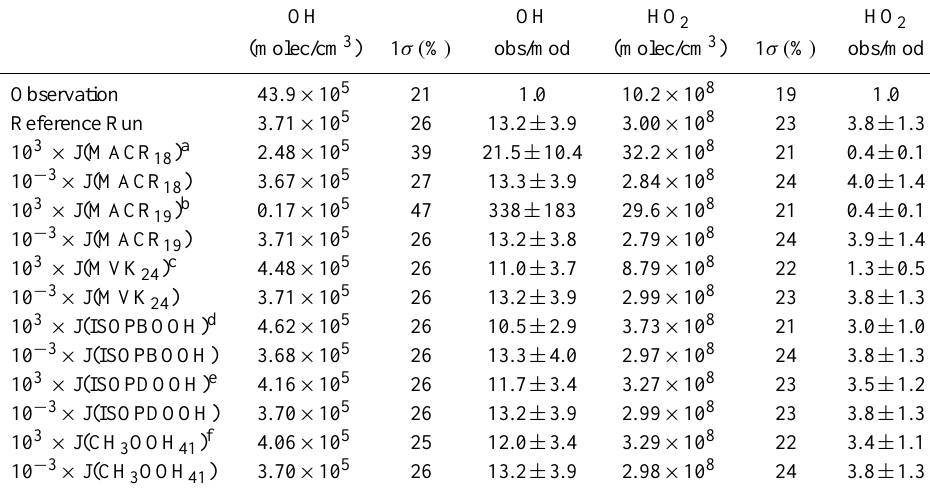
Table 6. Sensitivity studies of the photolysis frequencies concerning the isoprene chemistry of the MCM. Concentrations are mean values for the forest boundary layer ( < 1km) in the afternoon